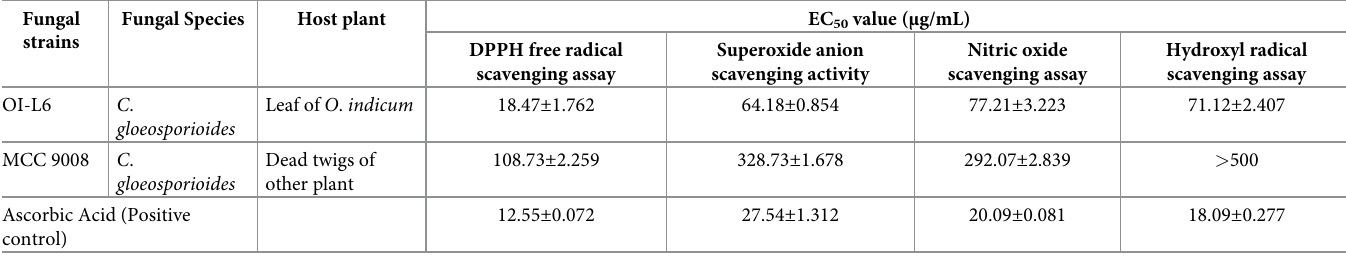
Table 4. Comparative antioxidant activity of EA extract of fungal strains C . gloeosporioides (OI-L6) and MCC 9008.